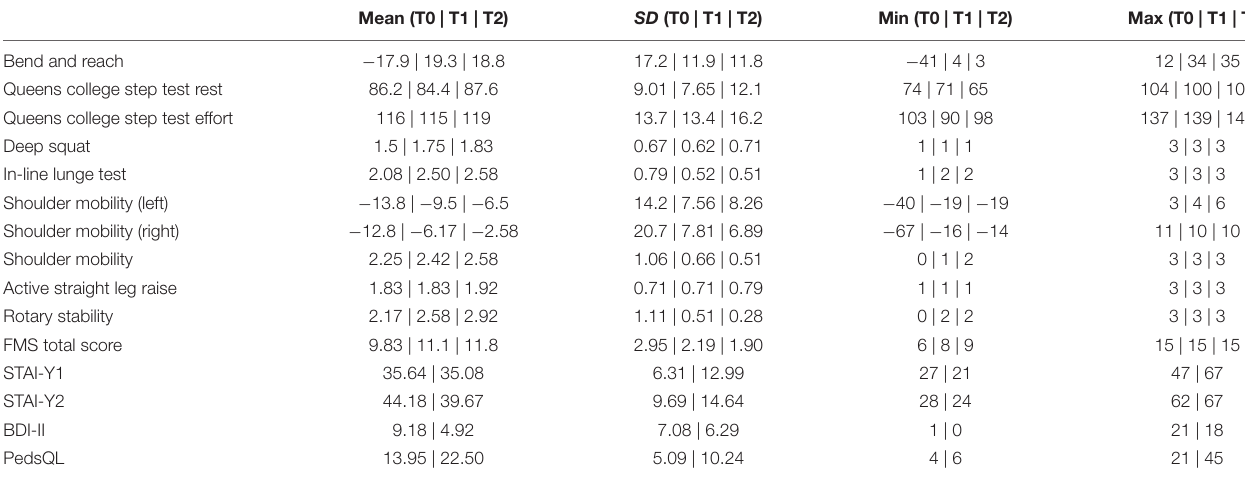
TABLE 1 | Descriptive analyses of psychological and motor tests of the entire sample ( n = 12).